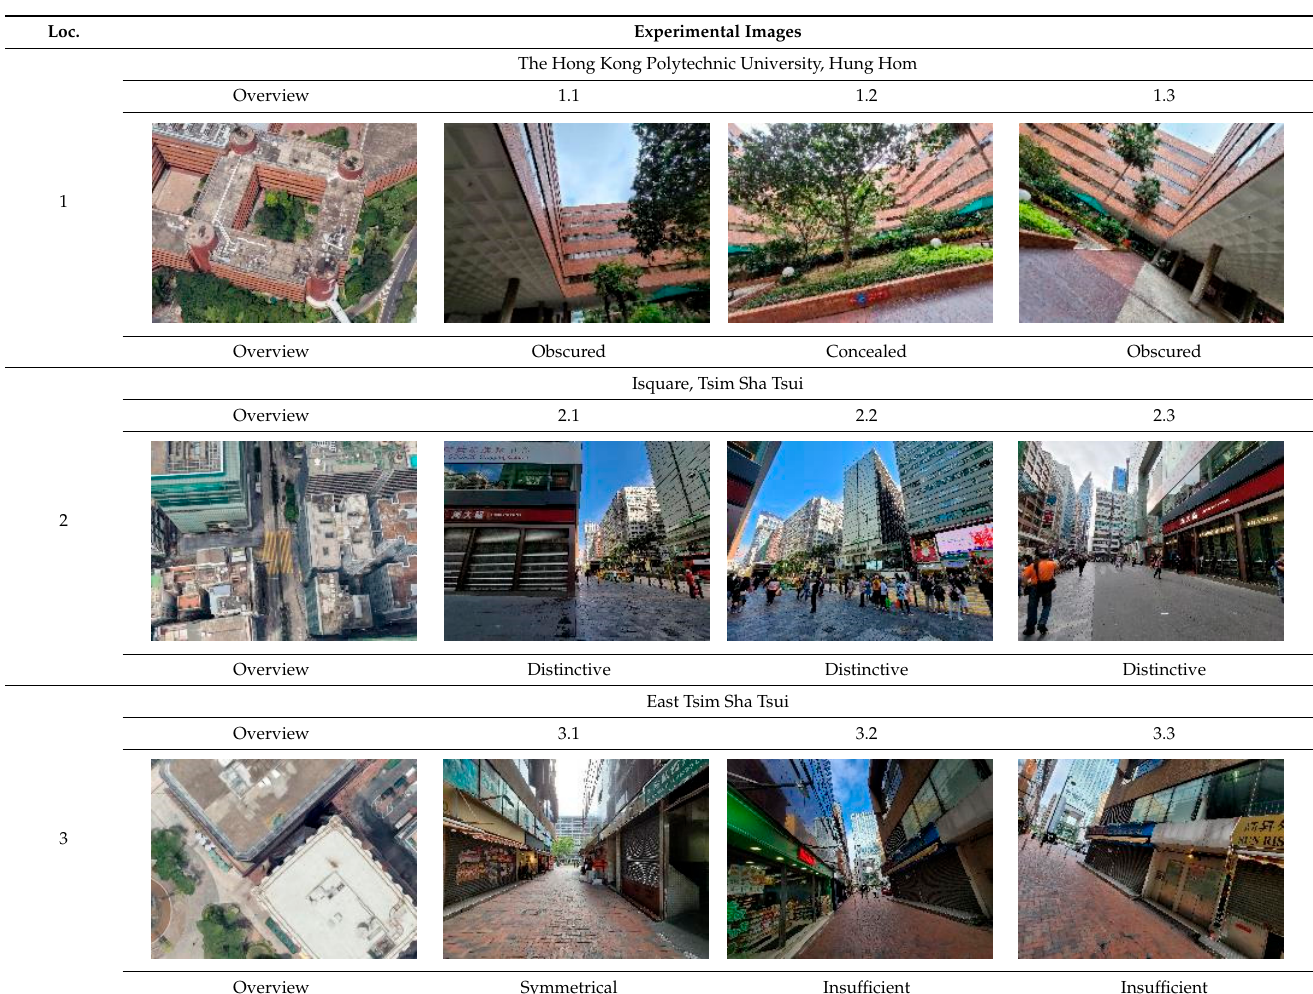
Table 3. Positioning performance comparison of the proposed semantic VPS and other advanced positioning algorithms.